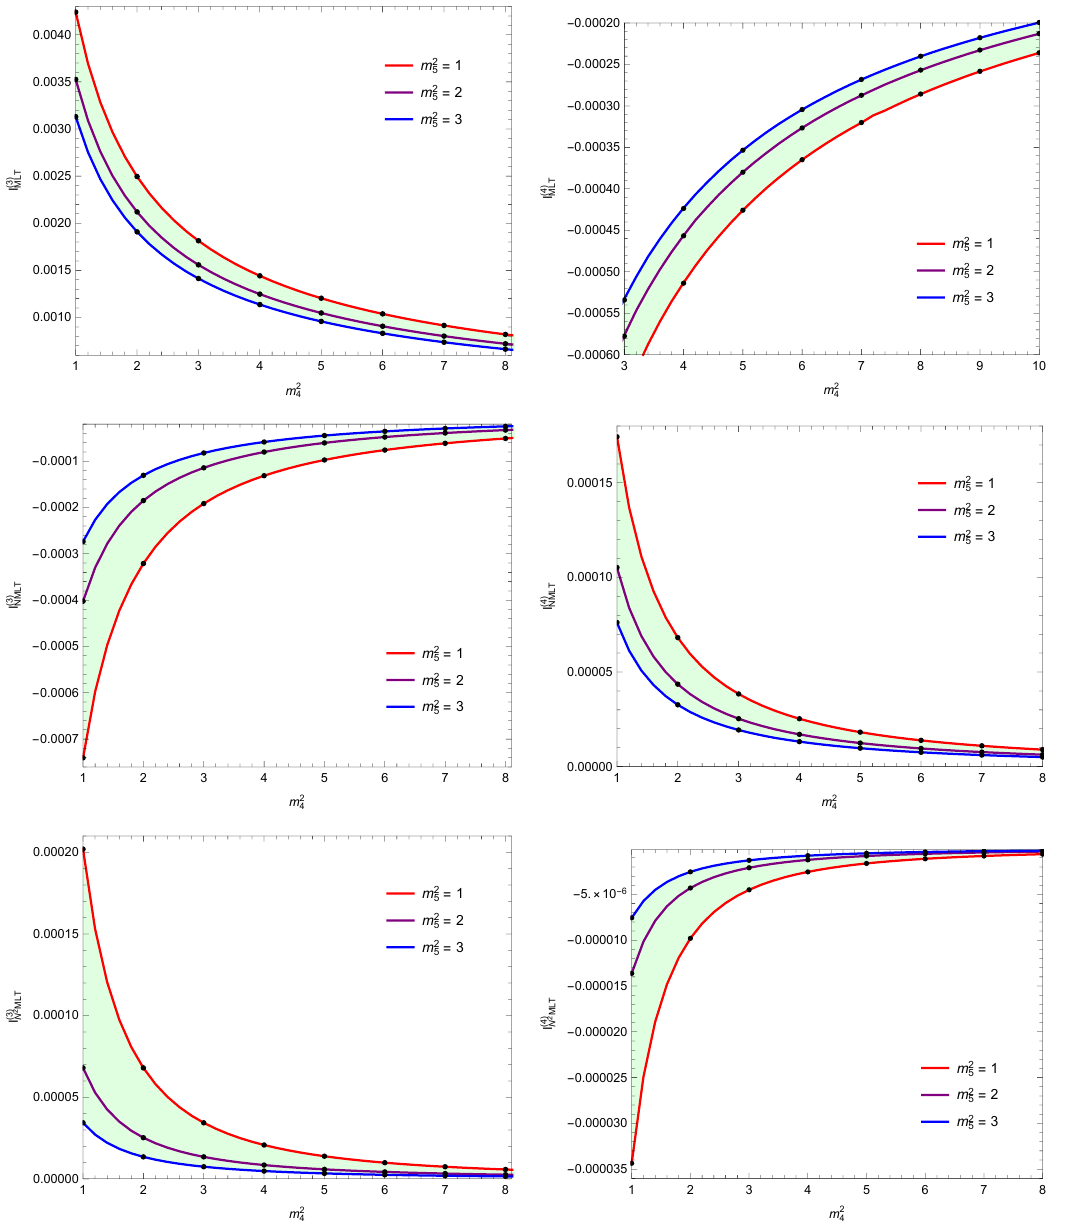
Figure 7 . Two-dimensional MLT, NMLT and N 2 MLT at three and four loops, as a function of the internal masses m 2 and m 2 . Solid lines correspond to the analytic results of LTD and dots to the 4 5 numerical results of Fiesta 4.2